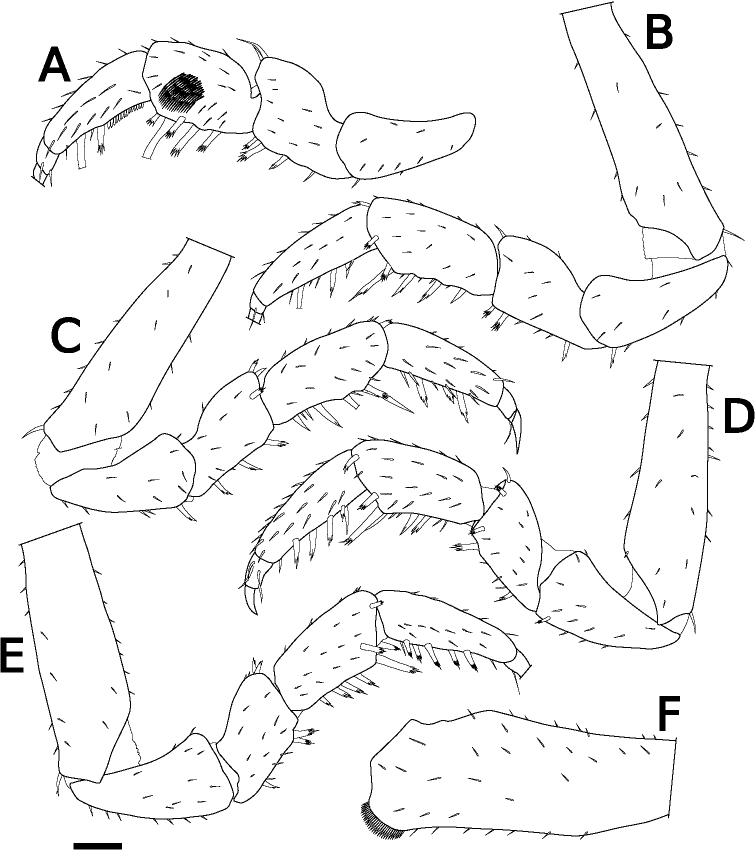
Sphaerillo
boninensisA pereopod 1, holotype (male) B–E pereopods 3–6, holotype (male) F basis of pereopod 7, holotype (male). Scale bar: 100 μm.